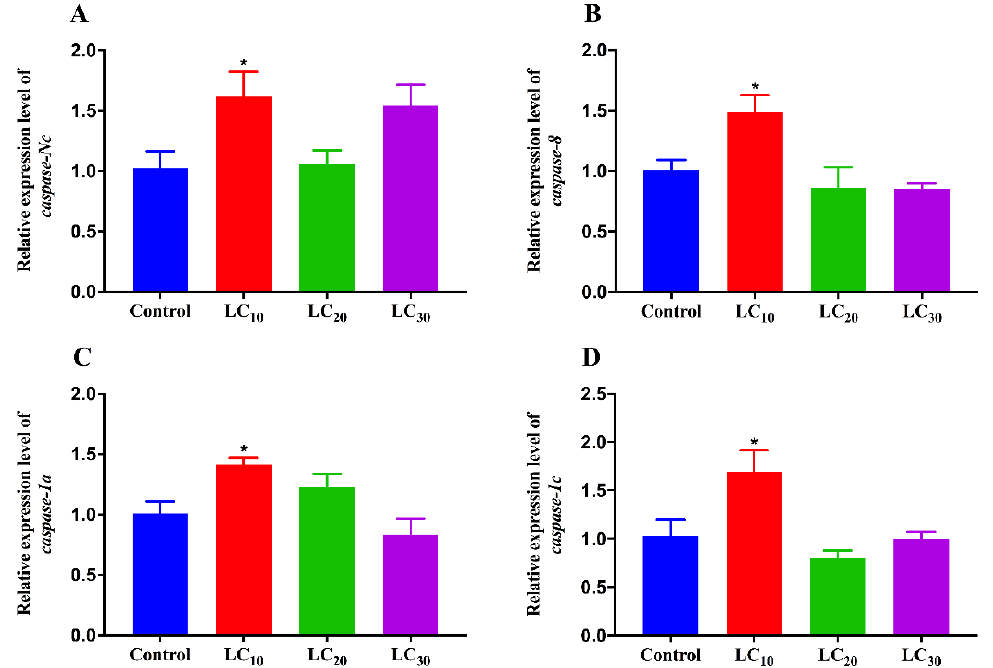
Figure 4. Transcript levels of caspases in the ovaries of viruliferous SBPH treated by sublethal concentrations of imidacloprid. ( A ) caspase - Nc ; ( B ) caspase - 8 ; ( C ) caspase - 1a ; ( D ) caspase - 1c . The asterisk indicates significant differences between the treatment and the control (Student’s t -test, * p < 0.05).